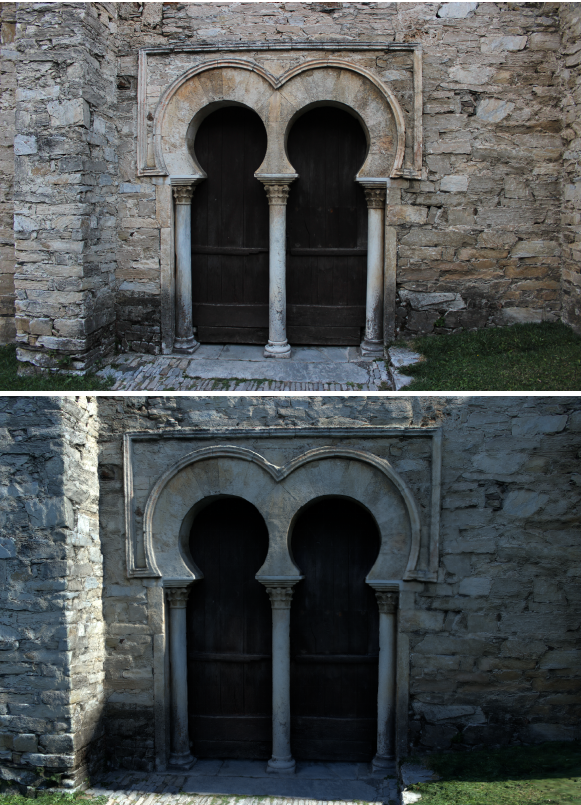
Figure 15: One of the original photographs (up) of the door of Santiago de Pe˜nalba, Leon, Spain and an synthetic view (down) of the 3D model with acquired appearance, rendered using phys- ically based methods for a different viewpoint and